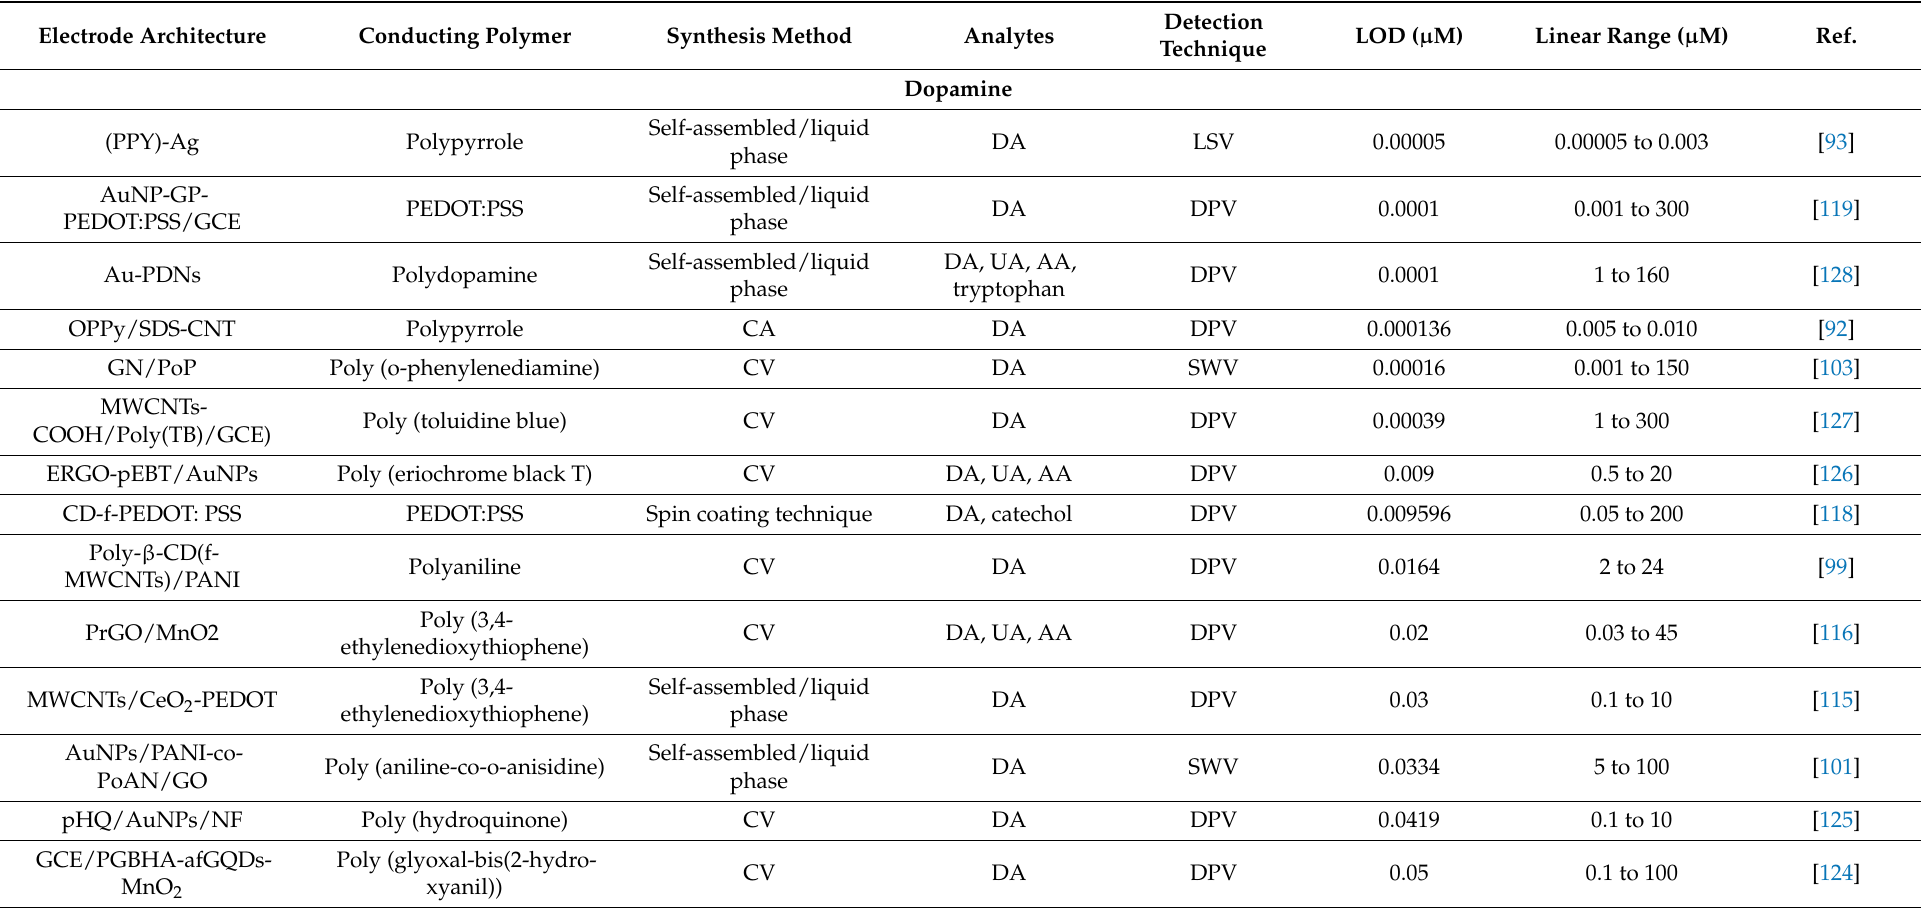
Table 1. Summary of the performance analysis of different electrochemical sensors based on conducting polymers for the aqueous detection of various molecules with a fundamental role in the human